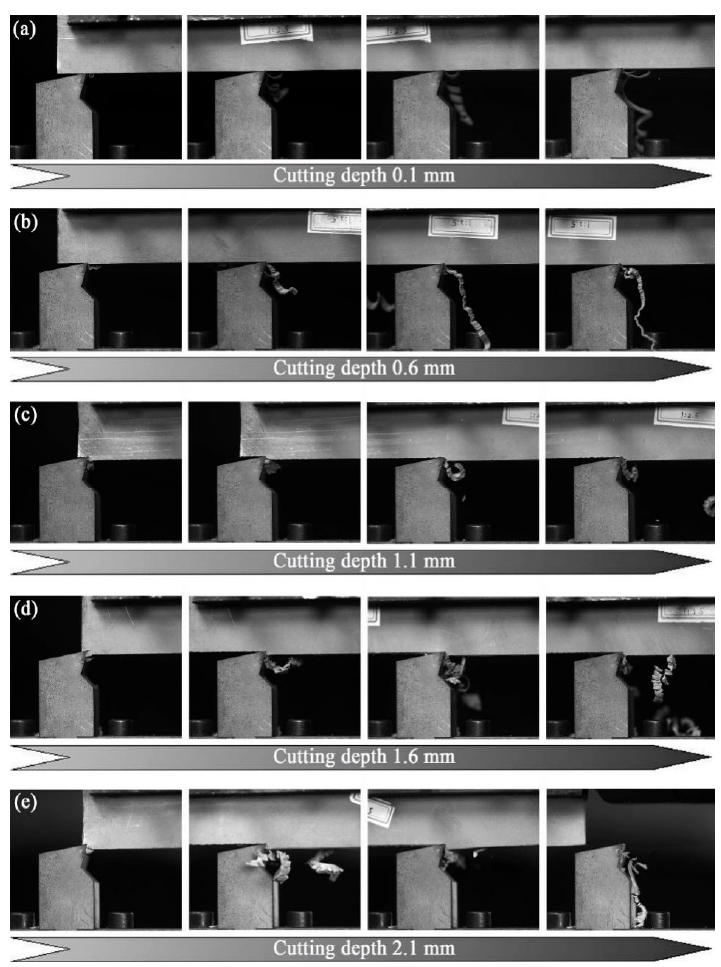
Figure 8. Chip formation at different cutting depths: ( a ) 0.1 mm, ( b ) 0.6 mm, ( c ) 1.1 mm, ( d ) 1.6 mm, and ( e ) 2.1 mm.